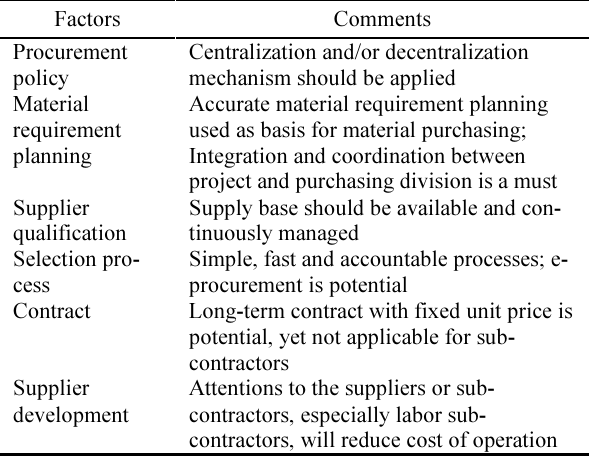
Table 2. Factors to be